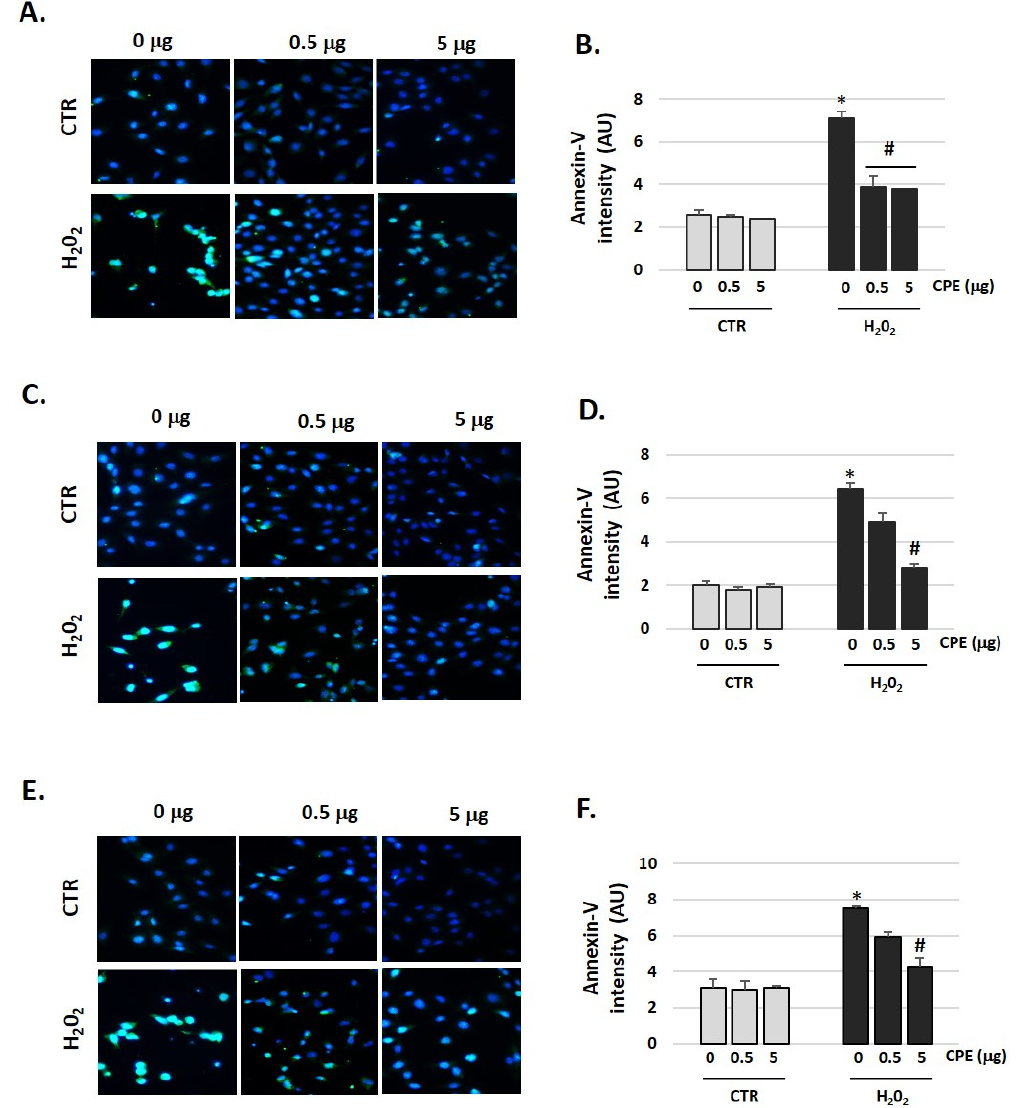
Figure 8. Cocoa decreased production of Annexin-V in senescence auditory cells. Representative fluorescence micrographs of immunostaining of Annexin-V in ( A ) HEI-OC1, ( C ) OC-k3, and ( E ) SV- k1 cell cultures post-treatments ( × 40). Nuclei were identified by DAPI (blue fluorescence), and Annexin-V immunoreactivity (green fluorescence). Representative images were taken at random in a blinded fashion. Bar graphs show the immunofluorescence intensity changes by Image J program for ( B ) HEI-OC1, ( D ) OC-k3, and ( F ) SV-k1 cells. Experimental groups: CTR group (0, 0.5 and 5 μ g/mL of CPE for 20 h) and H 2 O 2 group (induced cellular senescence with 100 μ M for 1 h in all groups: 0, 0.5 and 5 μ g/mL of CPE for 20 h). The values represent the mean ± SD Arbitrary units (AU) in triplicate. * p < 0.05 vs. CTR group; # p < 0.05 vs. H 2 O 2 group ( n = 4).